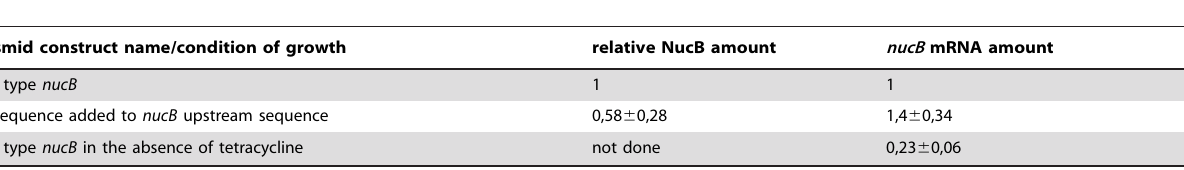
Table 1. NucB protein level in P. bryantii TC1-1 cultures harboring pRH3 constructs containing added SD sequence relative to the wild type upstream